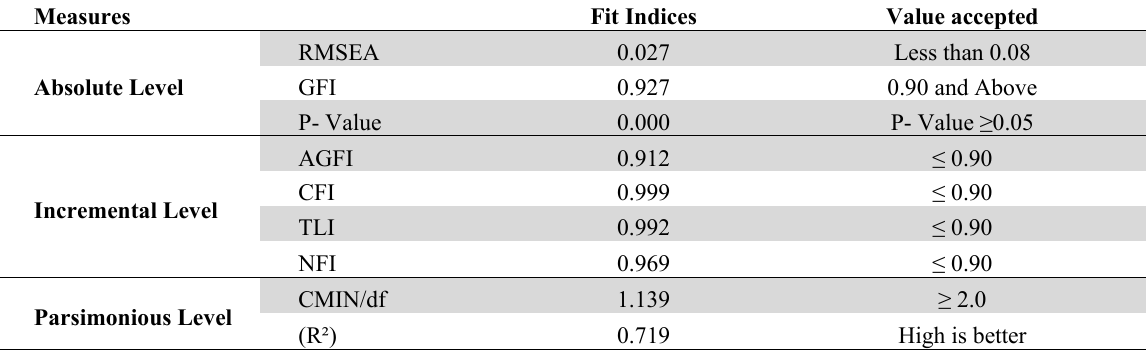
Good of Fit of the Hypothesized Model (GOF)